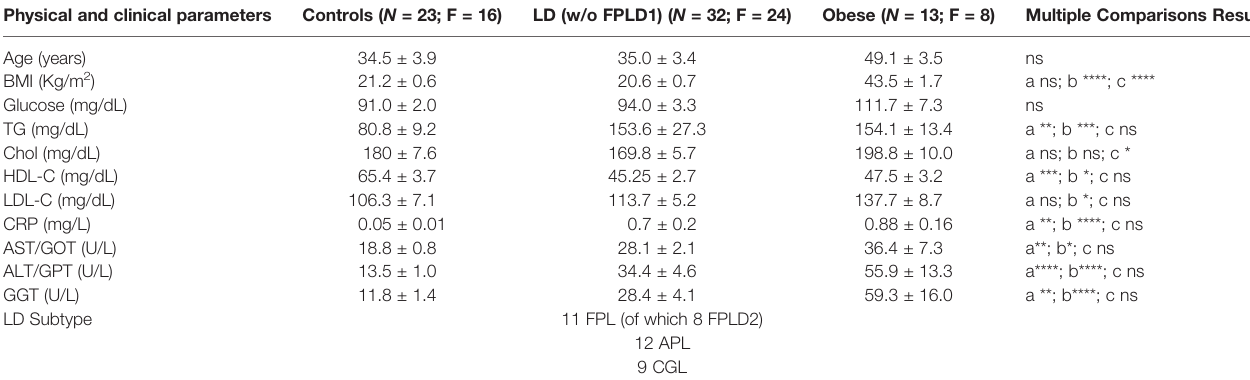
TABLE 1 | Physical and clinical parameters of subjects enrolled in the study * . Physical and clinical